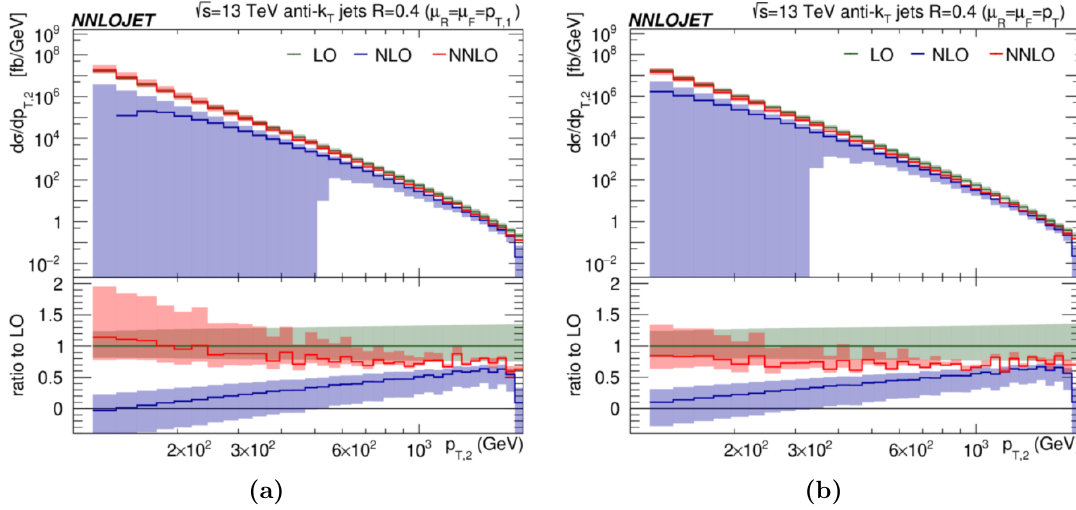
Figure 10 . Perturbative corrections to the transverse momentum distribution of the second jet at 13 TeV (CMS cuts, j y j < 4 : 7, R = 0 : 4), integrated over rapidity and normalised to the LO prediction. Central scale choice: (a) (cid:22) = p T ; 1 and (b) (cid:22) = p T . Shaded bands represent the theory uncertainty due to the variation of the factorization and renormalization scales.